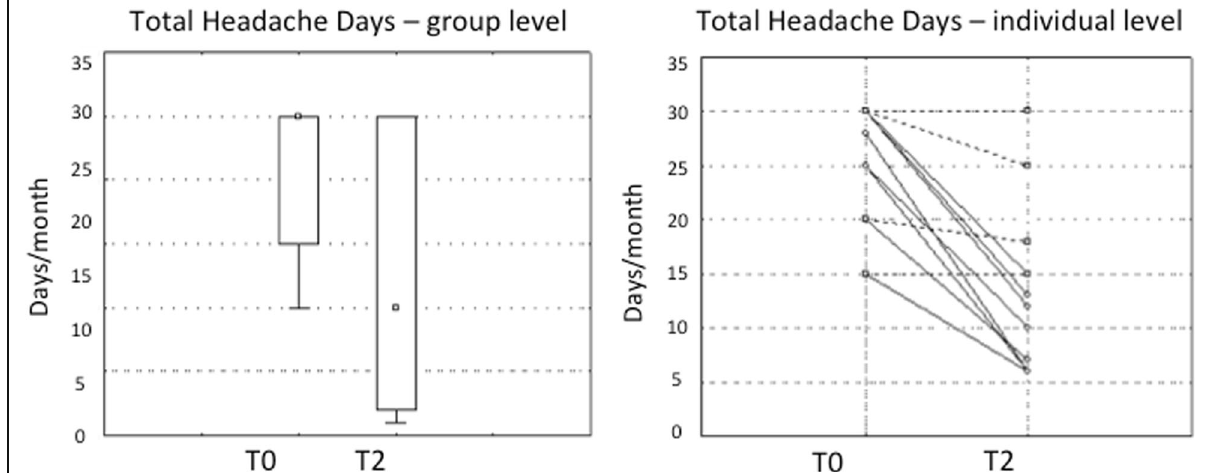
Fig. 2 Clinical effect at group and individual level. GON block was effective in reduce the average clincial burden of chronic migraine by 35%. More over we observed that after GON-B the majority of patients who responded reversed to EM. Only one case had a 15 days reduction but passed from 30 days to 15 days of headache remaining within the boundary of chronic migraine. Most of patients, who didn ’ t respond, had no benefit (five of them are 30 days to 30 days and then superimposed in the graph). Two Responders passed from 15 days to 6 days and are superimposed in the graph. Responders are in dotted, No-responders in continuous